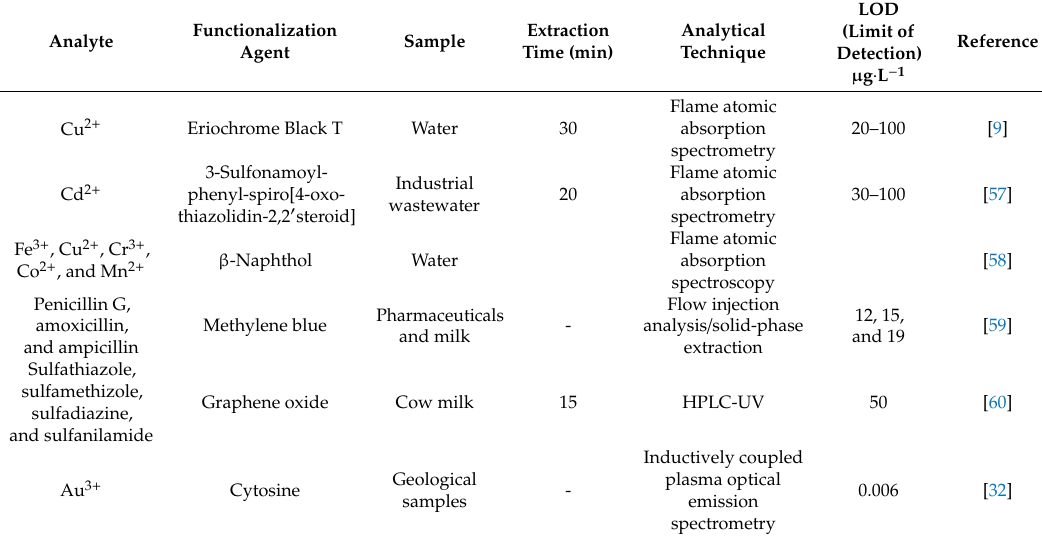
Table 2. Summary of the analytical methods developed, between 2005 and the present, based on PUFs. HPLC-UV: high-performance liquid chromatography with ultraviolet